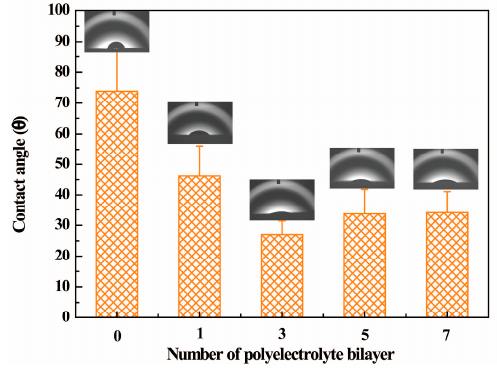
Figure 3. Contact angle of PET fabric with different bilayers of polyelectrolyte (PE) multilayer.